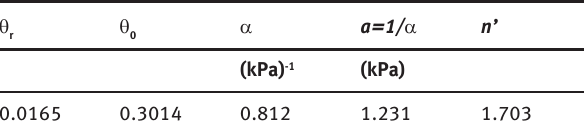
Table 7: WRC parameters for the drying phase following the first imbibition stage